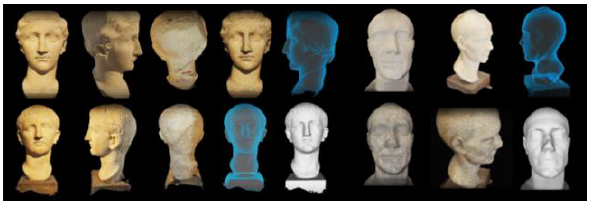
Figure 14. Head sculptures 3D models